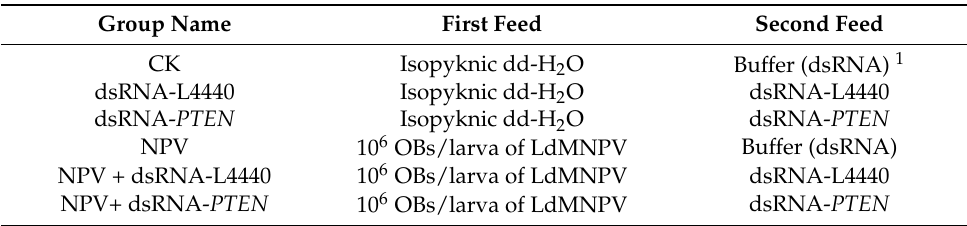
Table 1. Treatments of delivery dsRNA via